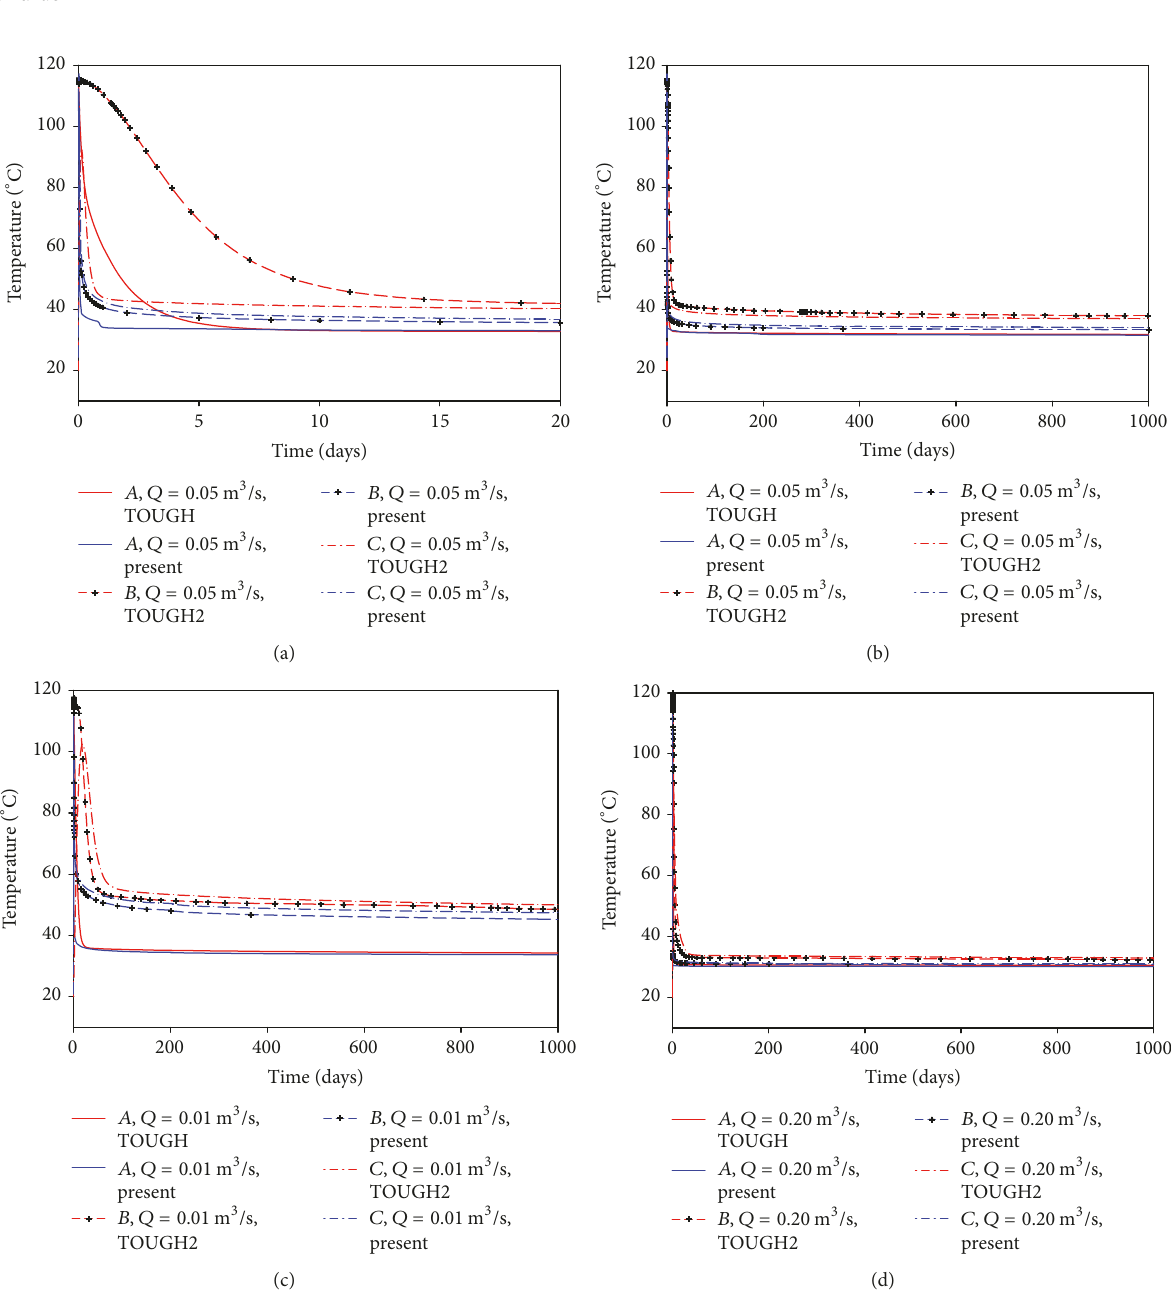
Figure 3: Comparison of the temperatures at points 𝐴 , 𝐵 , and C . (a) For small time and (b) for large time when 𝑄 = 0.05 m 3 /s; (c) for small 𝑄 = 0.01 m 3 /s and (d) for large 𝑄 = 0.2 m 3